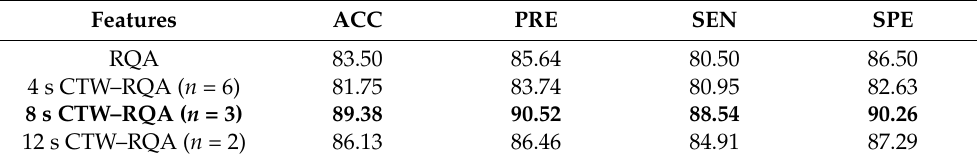
Table 5. AF detection performance based on RQA features and CTW–RQA features by means of RF.